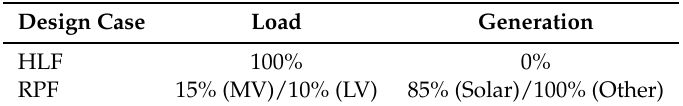
Table 5. Used Simultaneity factors of loads and generators in MV and LV grids for calculation of worst-case grid expansion costs based on